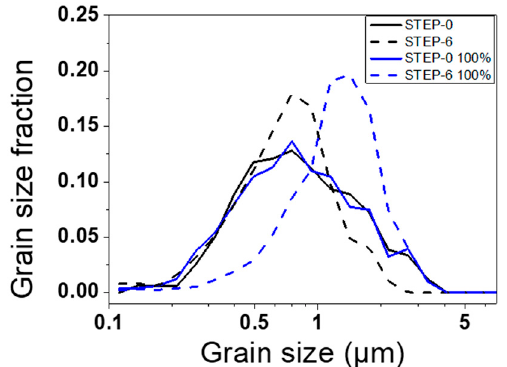
Figure 10. Distribution of grain sizes in STEP-0 and STEP-6 samples before and after applying a strain of 100% at 650 ° C and 10 − 3 s − 1 .